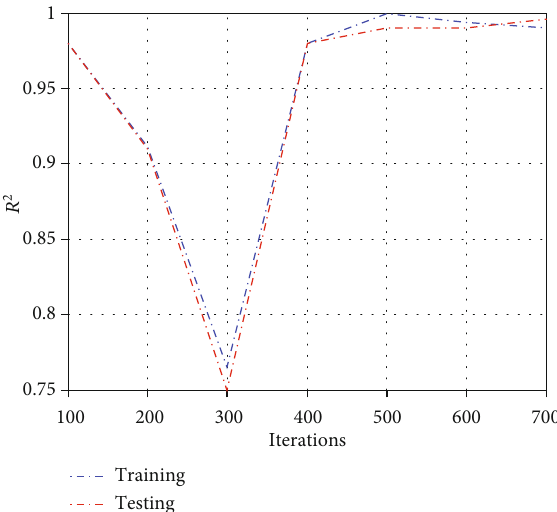
Figure 6: Coe ffi cient of determination.